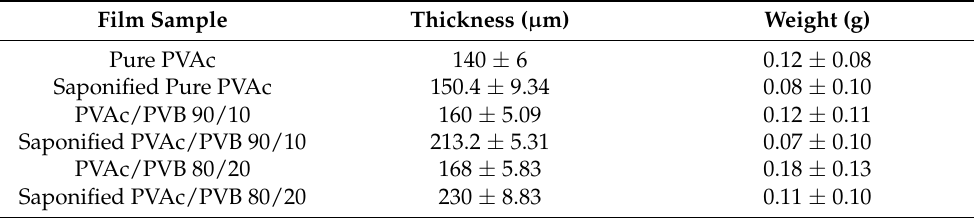
Table 1. Weight and thickness of saponified and unsaponified